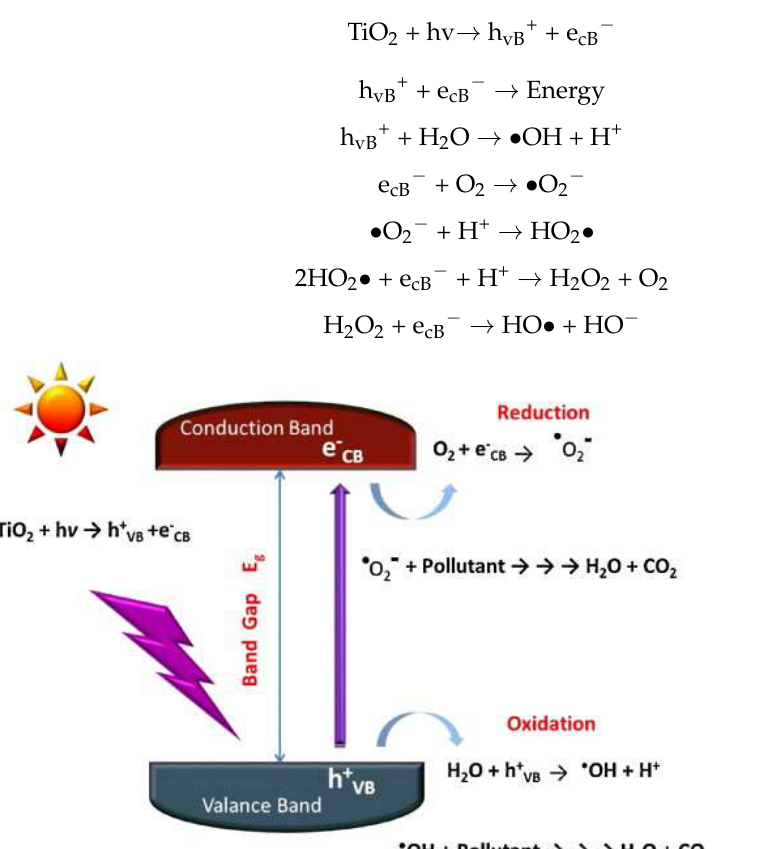
Figure 4. TiO 2 photocatalytic mechanism diagram [67].